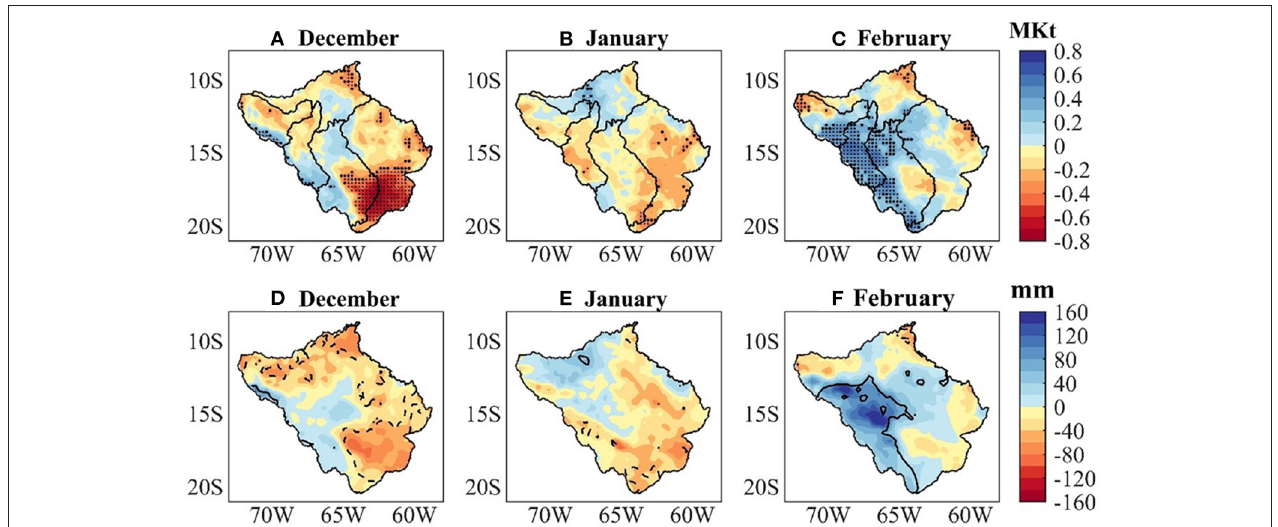
FIGURE 6 | Spatial distribution of Mann-Kendall coefficient (MK τ ) values ( p < 0.05 are displayed as dots and p < 0.10 as larger dots), indicating the trend for: (A) December, (B) January, and (C) February for the 2003–2017 period. Trends were computed in each CHIRPS.v2 rainfall grid at 0.25 ◦ of spatial resolution. The four tributaries’ sub-basins are plotted. Differences between the mean monthly rainfall for the 2010–2017 period minus the 2003–2009 period for: (D) December, (E) January, and (F) February in mm. After the Mann-Whitney test, significant at p < 0.10 are contoured, continuous lines for positive differences, and dash lines for